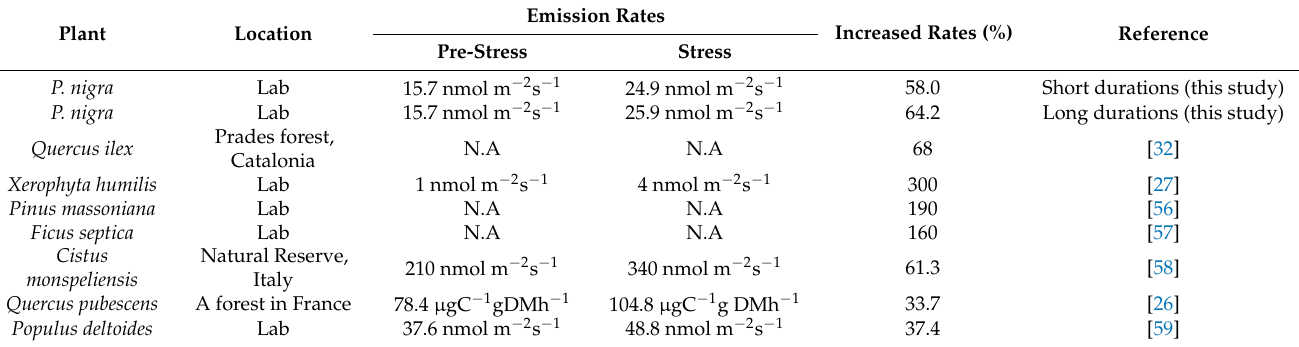
Table 1. Summary of increased rates on BVOCs emissions under drought